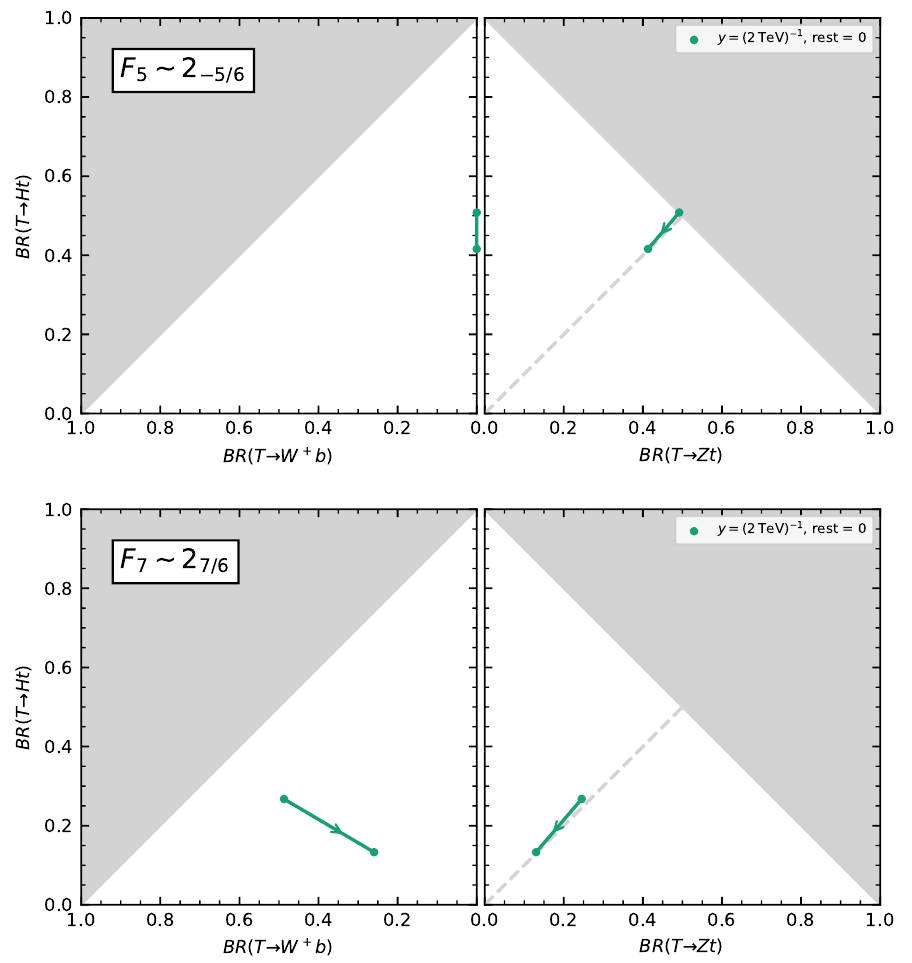
Figure 15 . Branching ratios of T into Ht , Zt and W + b for various values of the parameters in the F 1 and F 5 models.